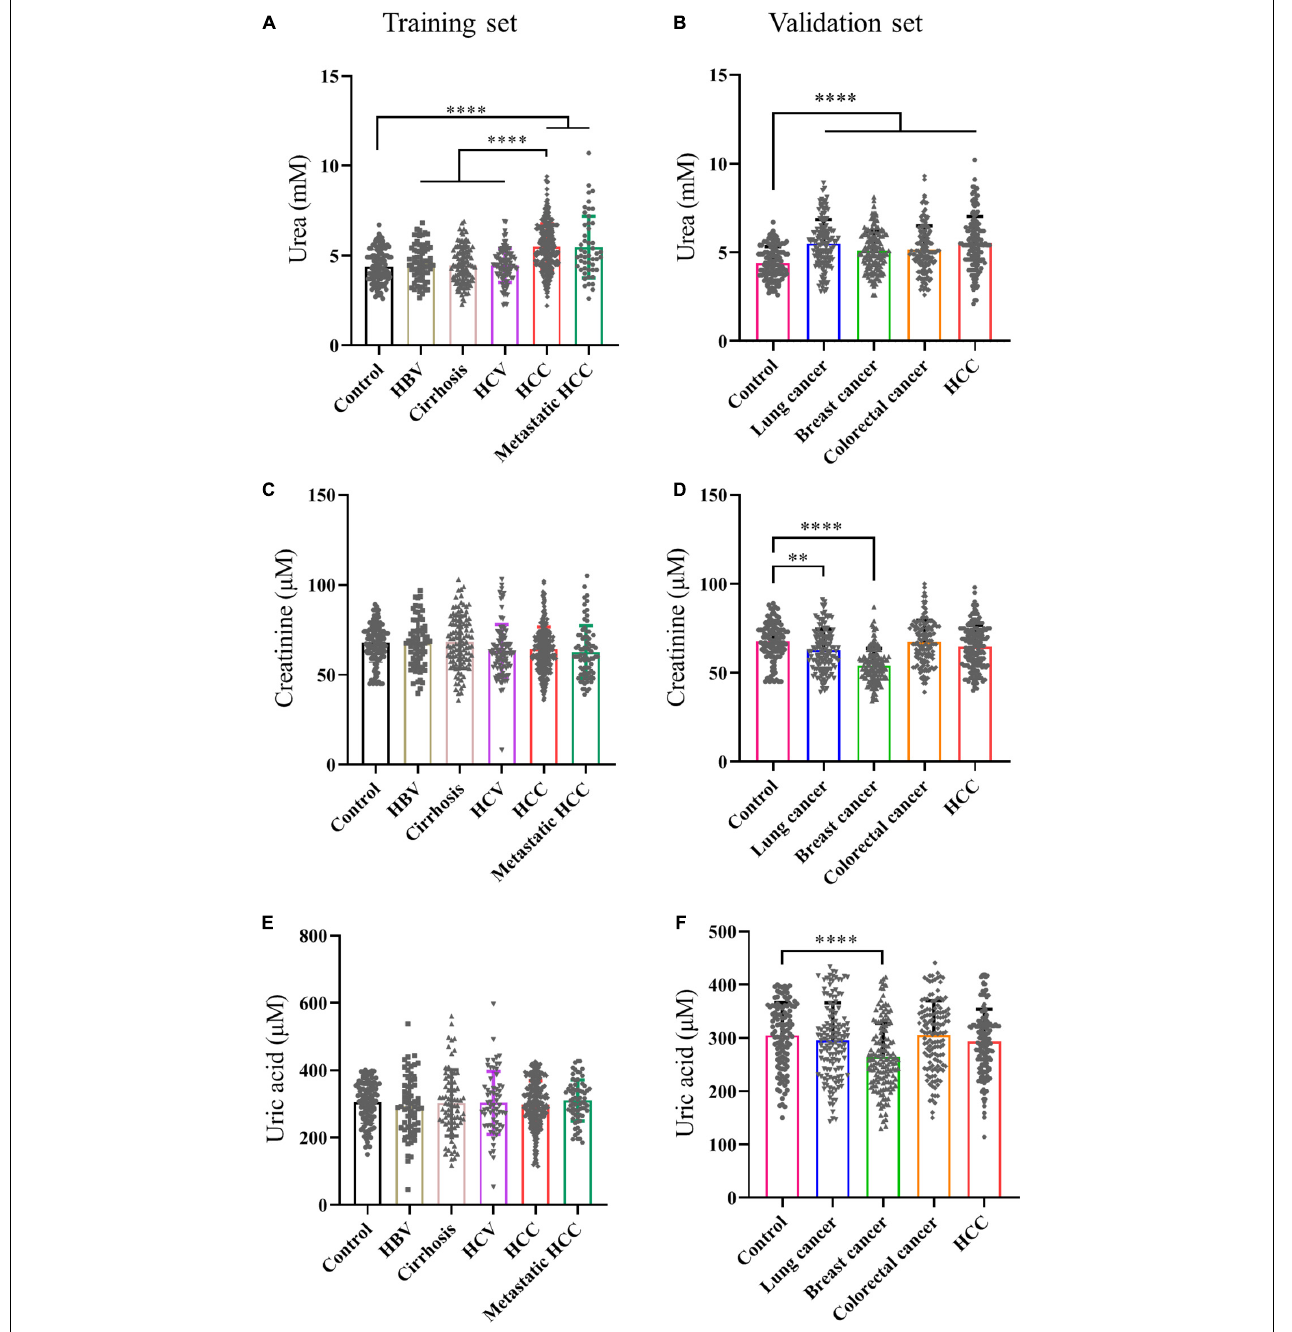
FIGURE 2 | Serum urea was a potential biomarker for HCC. (A,C,E) Scatter plots with bar of urea, creatinine and uric acid of control, HBV, Cirrhosis, HCV, HCC and metastatic HCC patients in training set. (B,D,F) Scatter plots with bar of urea, creatinine and uric acid of control, lung cancer, breast cancer, colorectal cancer and HCC patients in validation set. ∗ p < 0.05; ∗∗ p < 0.01, ∗∗∗ p < 0.001, ∗∗∗∗ p <